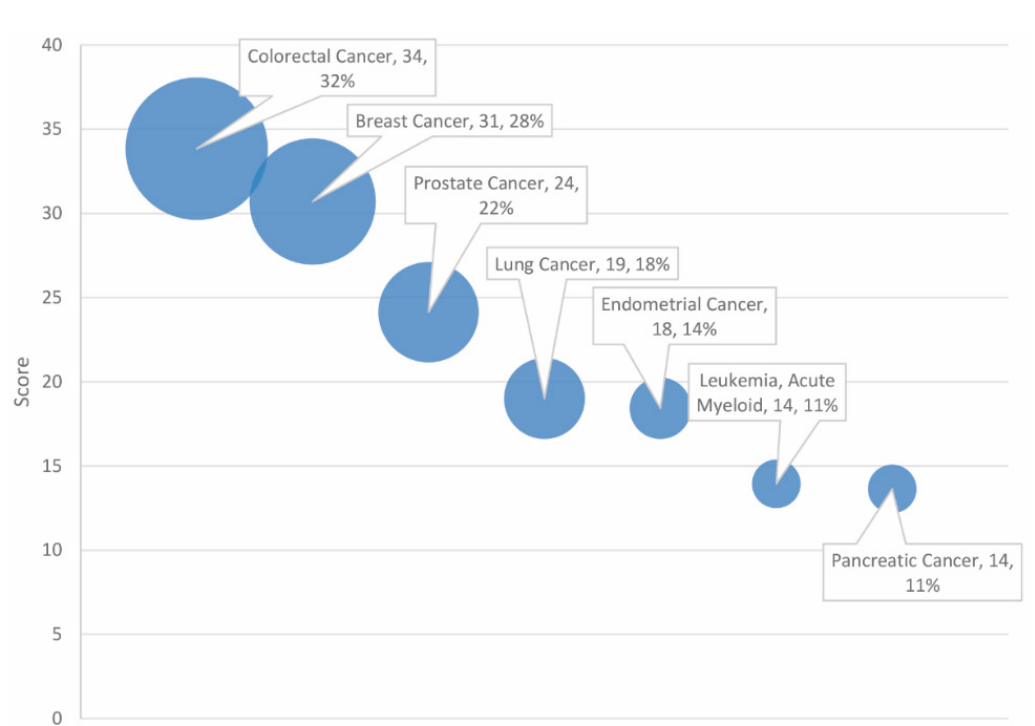
Figure 1. Diseases ranked by score and match rate (size of circle).